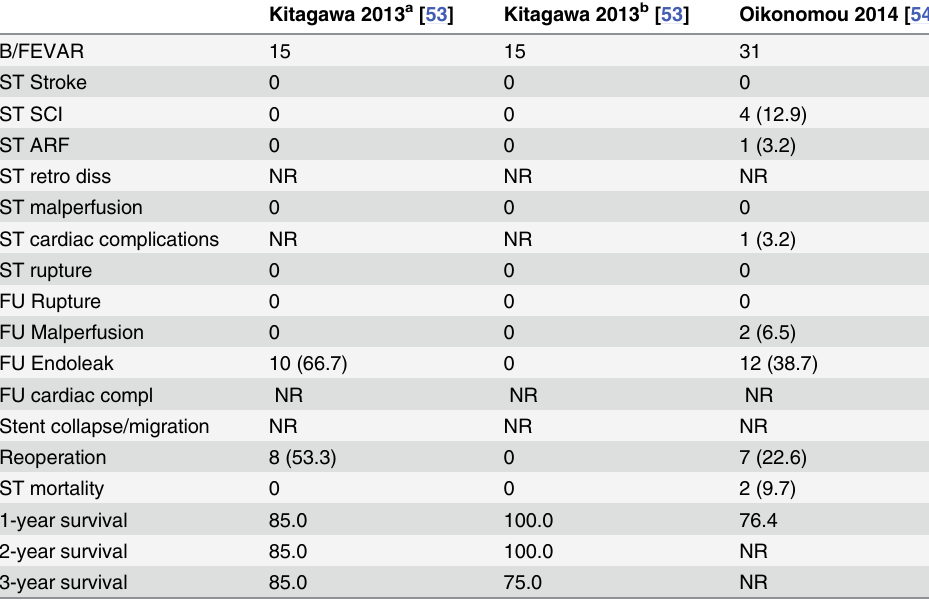
Table 3. Complications and survival B/FEVAR.